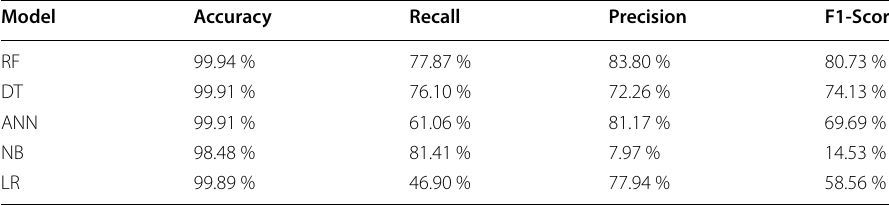
Table 5 Classification results for v 4